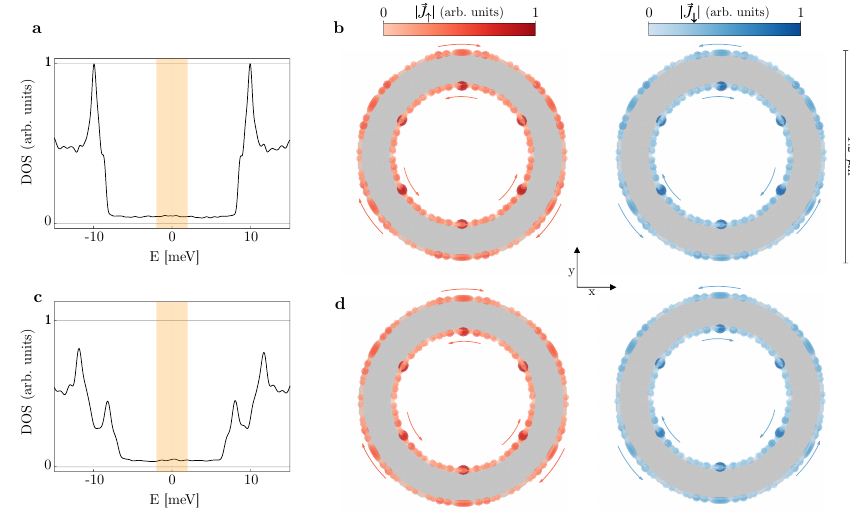
Figure 8: (a) Total density of states (DOS) of encapsulated bilayer graphene with- = 20meV, and with the shape of a circular out Rashba or Zeeman couplings, with λ I strip. The subgap DOS comes from edge states that remain ungapped all along the boubdaries of the sample, which span all crystallographic orientations from arm- chair to zigzag. The edge states carry a spin current, shown in (b) for states within the yellow strip. The current is not suppressed by the varying edge orientation, since localization would require spin-flip-backscattering. Curved arrows indicate current direction, and colored circles encode current magnitude. (c,d) The same as in (a,b) but with the addition of Anderson disorder of amplitude 2meV and zero average, dis- tributed throughout the sample. Again, the spin-independent nature of the disorder leaves the edge states unperturbed, even though the DOS around and above the gap edge is strongly